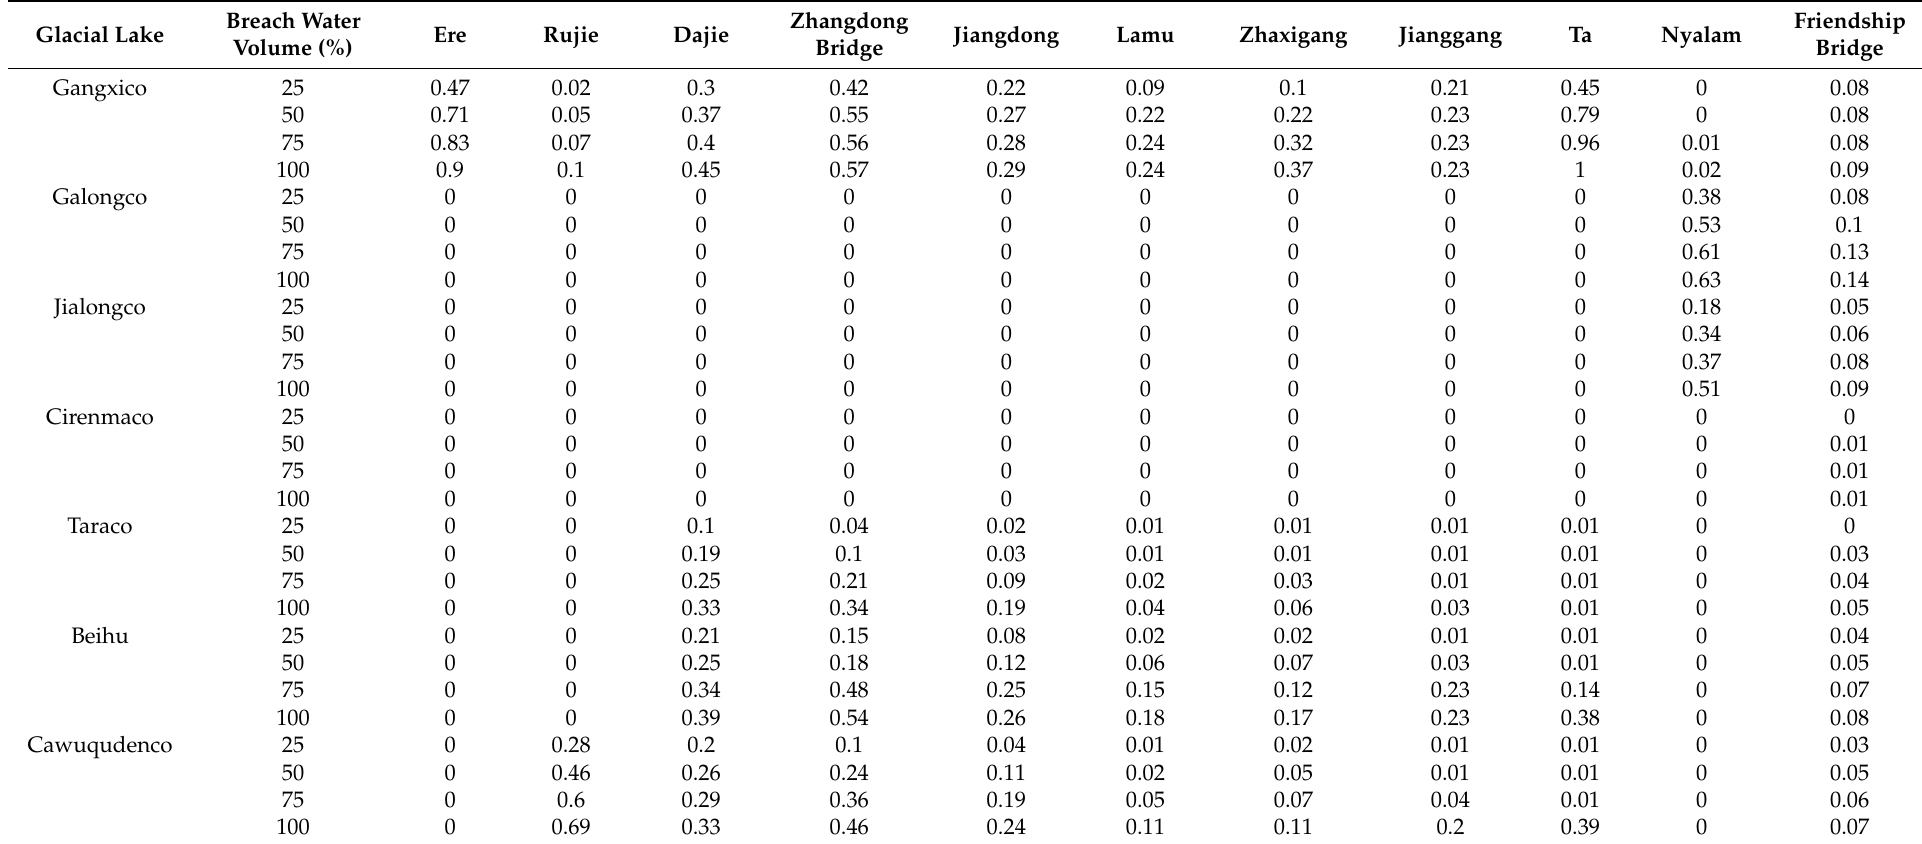
Table 5. Potential impact of GLOFs from different glacial lakes on downstream villages and towns. The values are in the range of 0–1, which is calculated from the number of submerged buildings, farmland, roads, and bridges between the sections of the villages. It represents the exposure of communities and infrastructure to the risk of